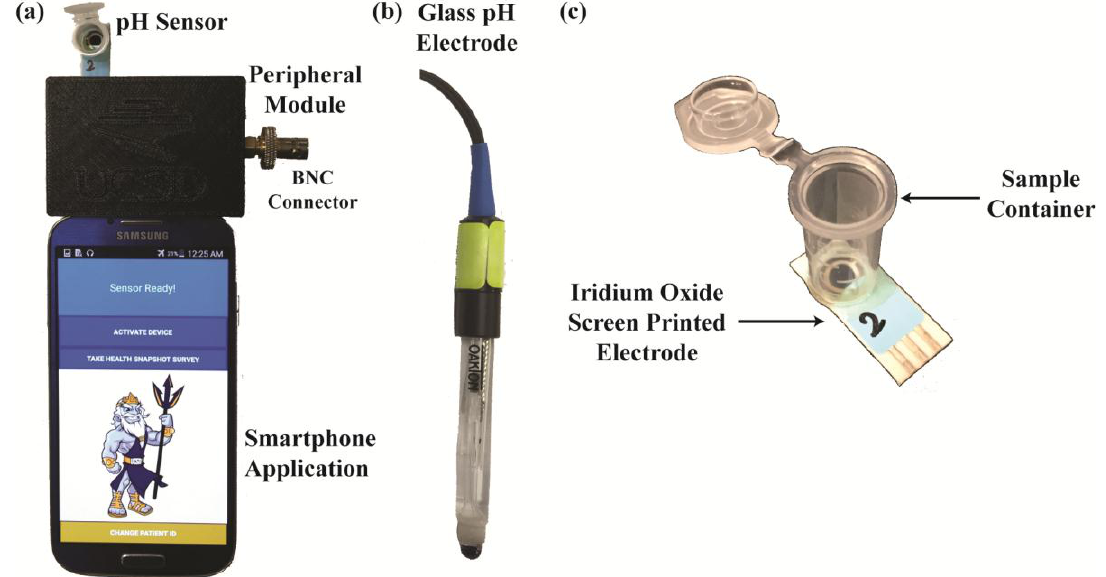
Figure 4. ( a ) Entire platform with the peripheral module inside a 3D-printed case, pH sensor chip, and smartphone running the custom CF application. Both ( b ) standard glass pH electrodes and ( c ) Iridium Oxide modified screen-printed electrodes can be used with this system.